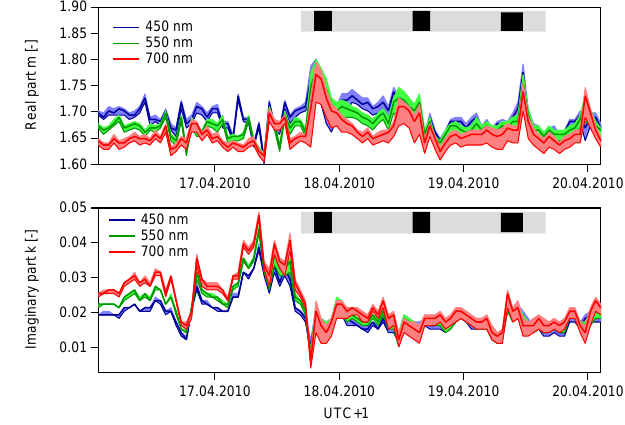
Fig. 10. Mean complex refractive index for the total Jungfraujoch aerosol retrieved from nephelometer, aethalometer and size distri- bution measurements using Mie theory (assuming a 60 × 60 matrix of real and imaginary parts). The shaded areas show the variability if the maximum and minimum values of the corrected Jungfraujoch size distributions are used, see Fig. A4. The horizontal bars mark the presence (gray) and maximal influence (black) of the volcanic aerosol